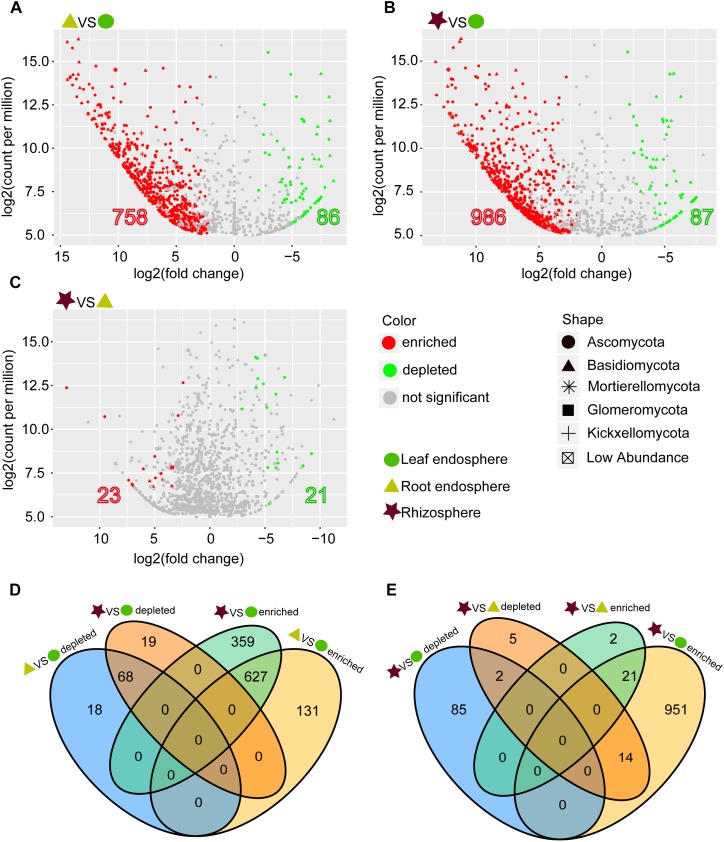
(A–C) Enrichment and depletion of the fungal OTUs in the three compartments compared with each other as determined by differential abundance analysis. (D–E) Numbers of differentially enriched OTUs and depleted OTUs between each compartment compared with each other.